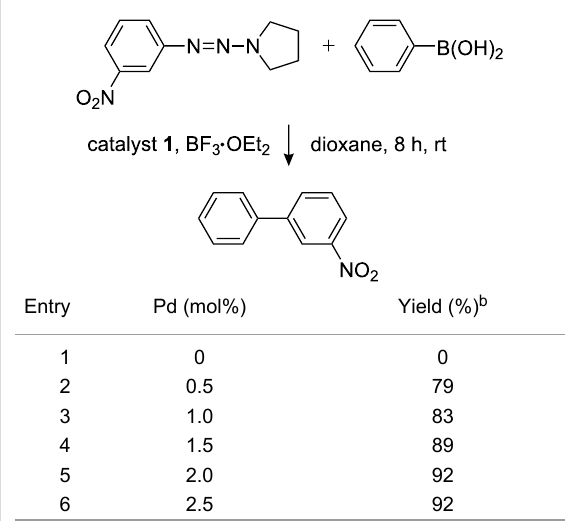
Table 2: Effect of the catalyst loading on the cross-coupling reaction a .